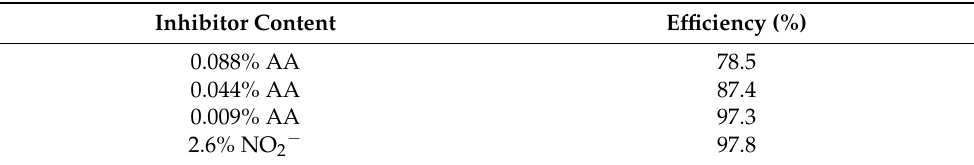
Table 3. Inhibitor efficiency of 2% chloride-contaminated mortars.